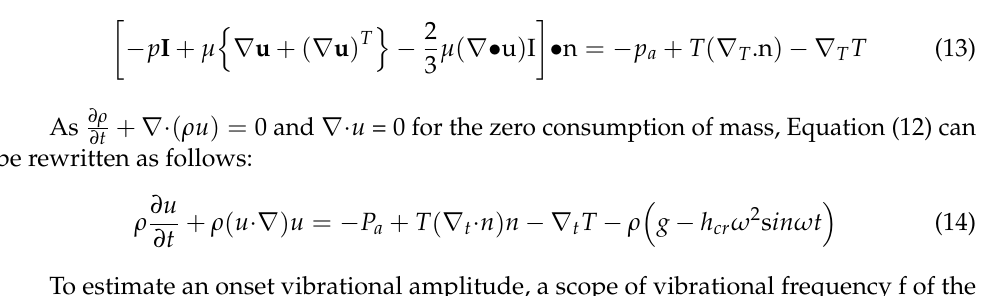
Figure 6. The frequency spectrum at the position ( Ｌ /2, h ) for h cr = 0.36 μ m . The frequency in the Y -axis stayed within a limited range, as depicted in Figure 6.